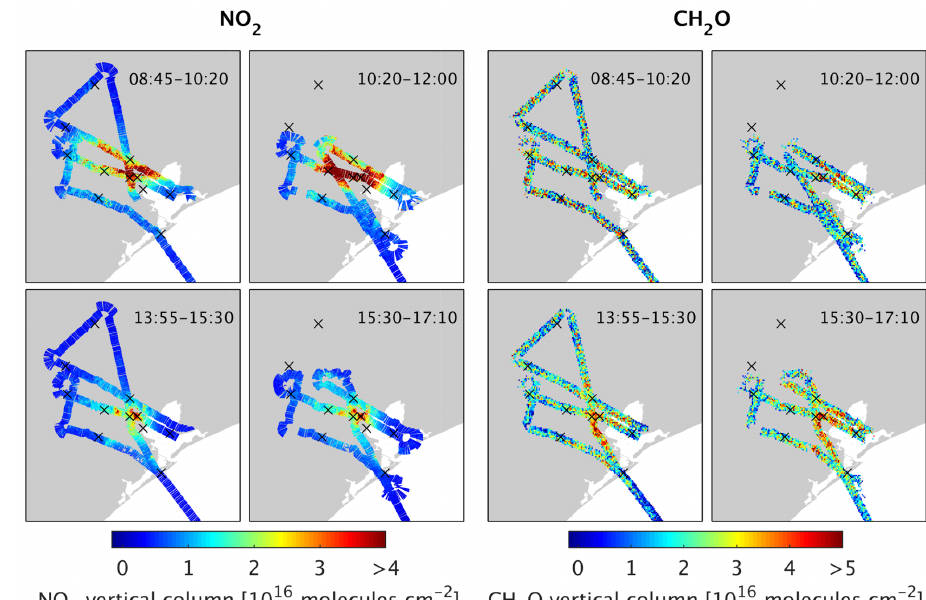
Figure 4. Same as Fig. 3 but for 25 September